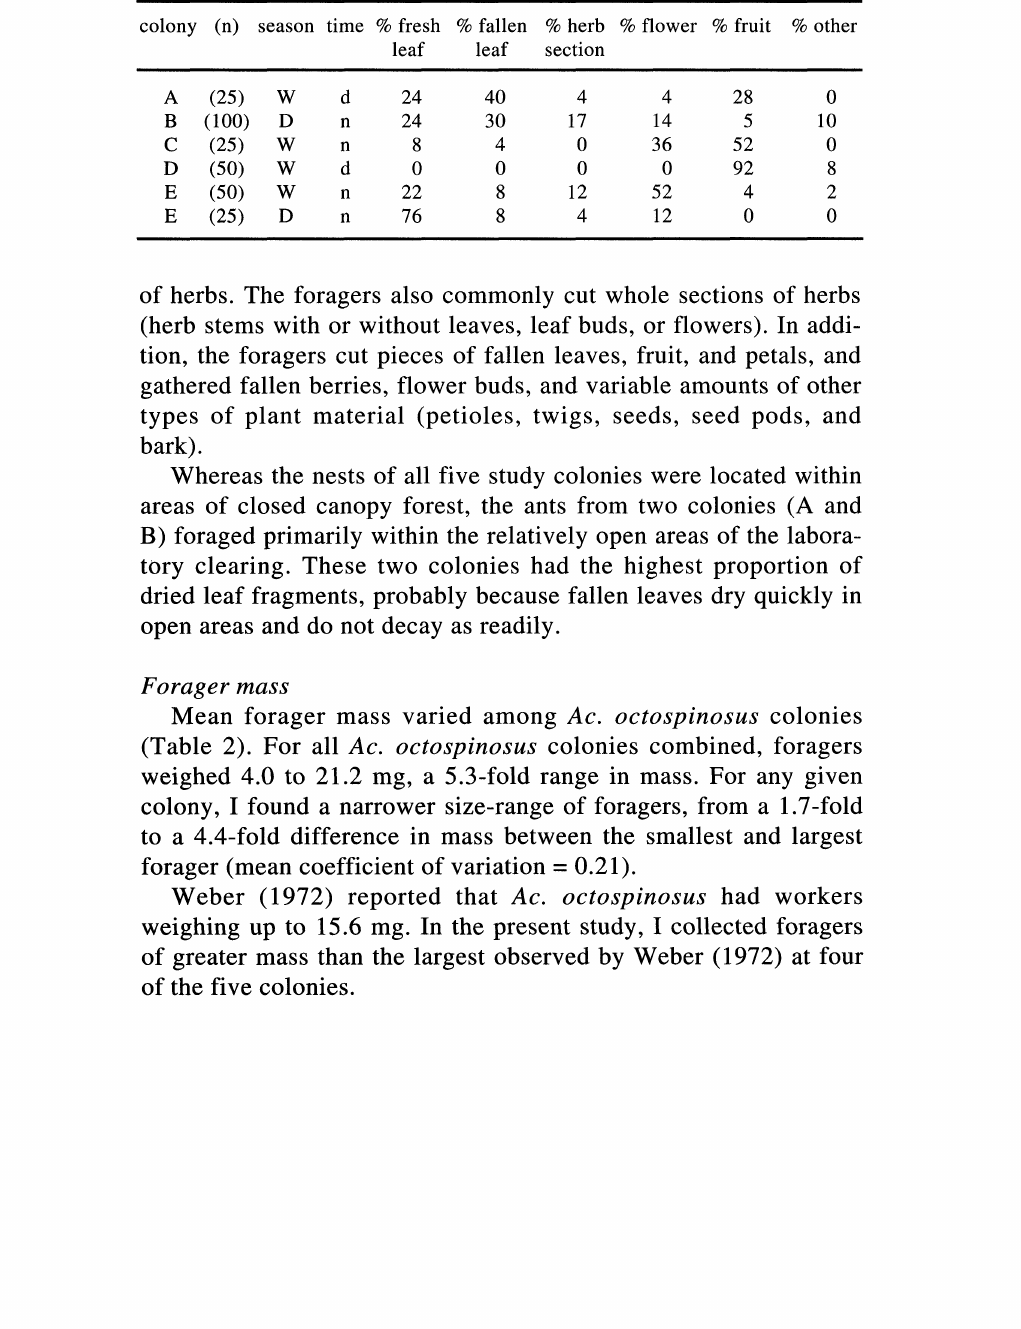
Table 1. Foraging selectivity by five different colonies of Acromyrmex octospinosus (colonies A, B, C, D and E; season: W wet, D dry; time of forag- ing: d primarily diurnal, n primarily